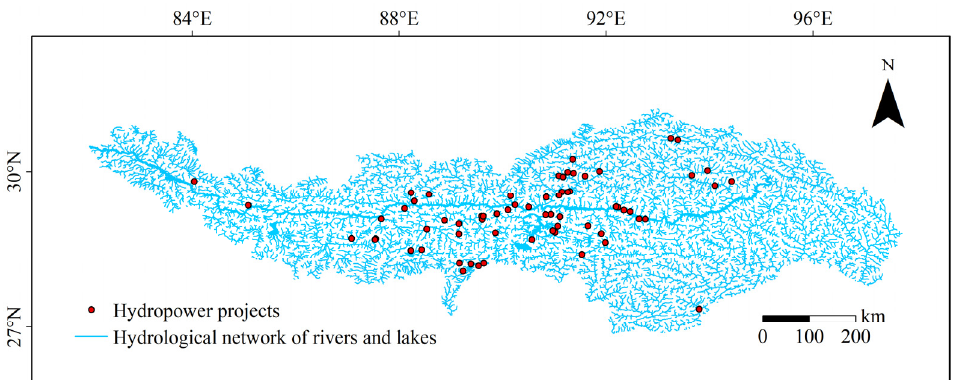
Figure 2. Distribution sketch map of the hydropower projects in Yarlung Tsangpo River